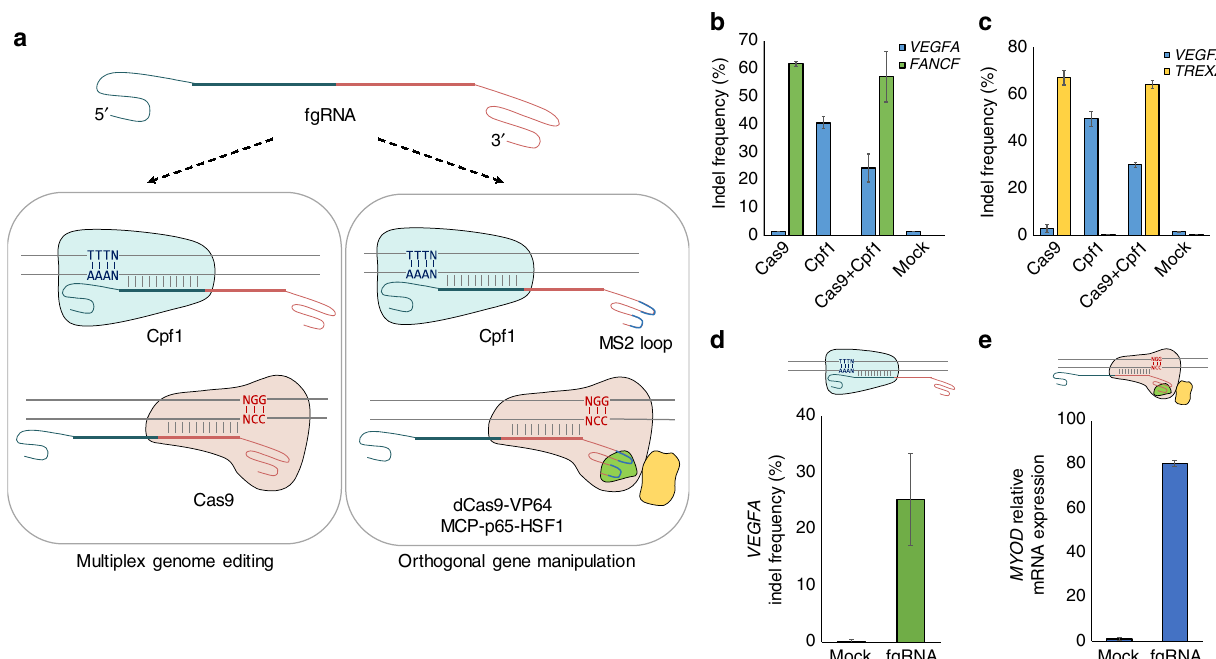
Fig. 4 Multiplex genome manipulations with fgRNAs. a Schematic overviews of multiplex genome editing and orthogonal genome manipulation. fgRNAs containing two different target sequences of Cpf1 and Cas9 could be used in multiplex genome editing with Cpf1 and Cas9. If these fgRNAs are used with Cpf1 and the dCas9 effector (i.e., dCas9-VP64), genome editing and regulation can be simultaneously performed. b , c Multiple genome editing with three different fgRNAs. fgRNAs were used with Cpf1 and Cas9 to target human VEGFA and FANCF ( b ), and human VAGFA and TREX2 ( c ). d , e Orthogonal gene disruption at the endogenous VEGFA locus ( d ) and transcriptional activation of endogenous MYOD genes ( e ). Error bars indicate s.e.m. ( n = 2 or